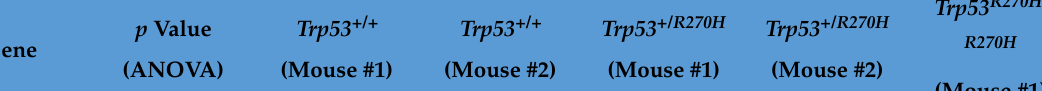
Table 2. The Trp53 R270 mutant allele mediates alterations in expression levels of validated tran- scriptional targets of the Trp53 R270H allele as well as alterations in expression levels of genes associated with incidence of prostate cancer in patients. Two known transcriptional targets of Trp53 R270H , Mgmt and Id4 , demonstrated differential expression in wildtype ( Trp53 +/+ ) versus het- erozygous ( Trp53 +/R270H ) and/or or homozygous mice ( Trp53 R270H/R270H ). A dose-dependent effect was observed for Mgmt . The expression of 4 genes which are associated with prostate cancer incidence and/or disease progression ( Cdkn1a , Kras , Raf1 , and Cav1 ) were impacted by the presence of the Trp53 R270H allele. A gene dosage effect was observed for 1 of these, Cdkn1a . Data shown are fragments per kilobase of exon model per million mapped reads